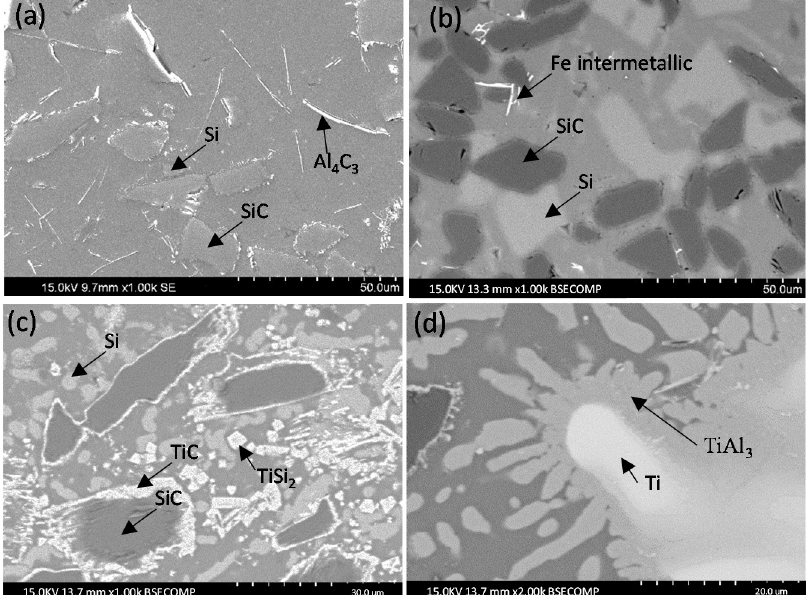
Figure 2. Microstructure of the coatings deposited on the AA6082 alloy: ( a ) Al12Si / SiC; ( b ) Al40Si / SiC; ( c ) Al12Si-Ti / SiC; ( d ) detail of the Al12Si-Ti / SiC.